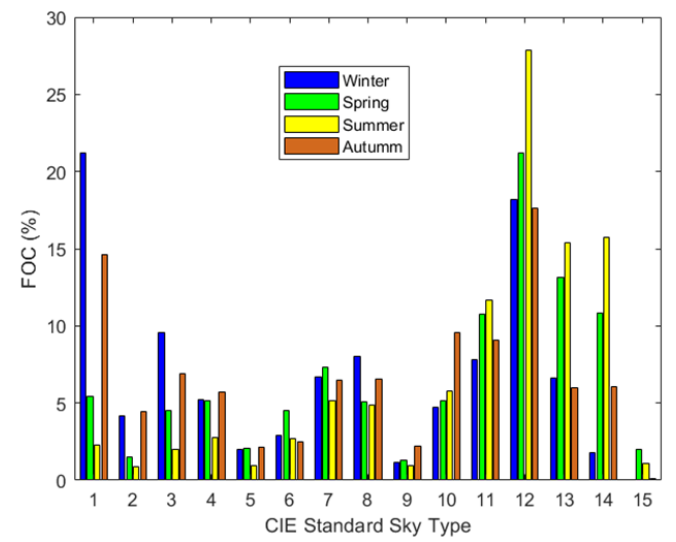
Figure 7. Seasonal FOC of the different CIE standard sky types in Burgos, Spain, between September 2016 and January 2019.